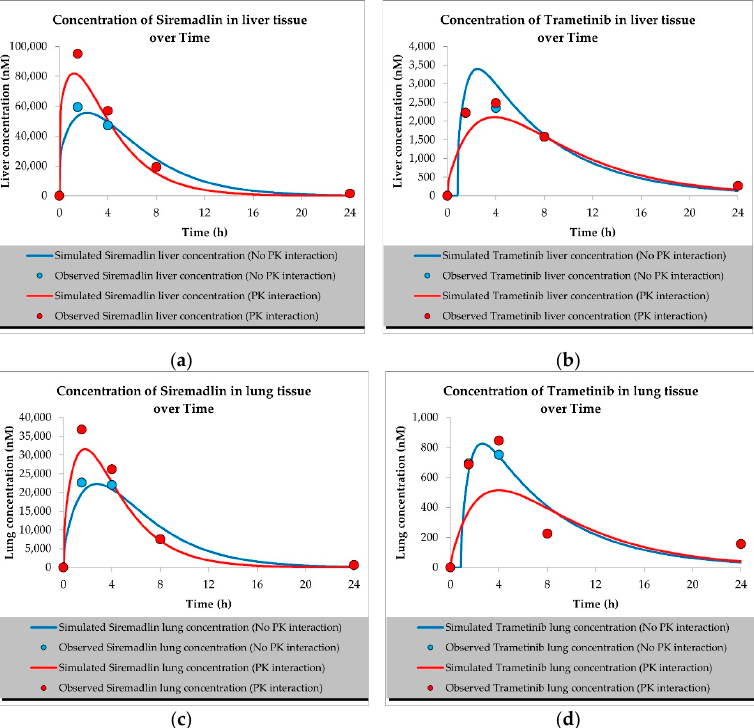
Figure 4. Values of predicted concentrations with and without PK interaction for ( a ) siremadlin and ( b ) trametinib in heart tissue; ( c ) siremadlin and ( d ) trametinib in kidney tissue; observed data are means from n = 3.